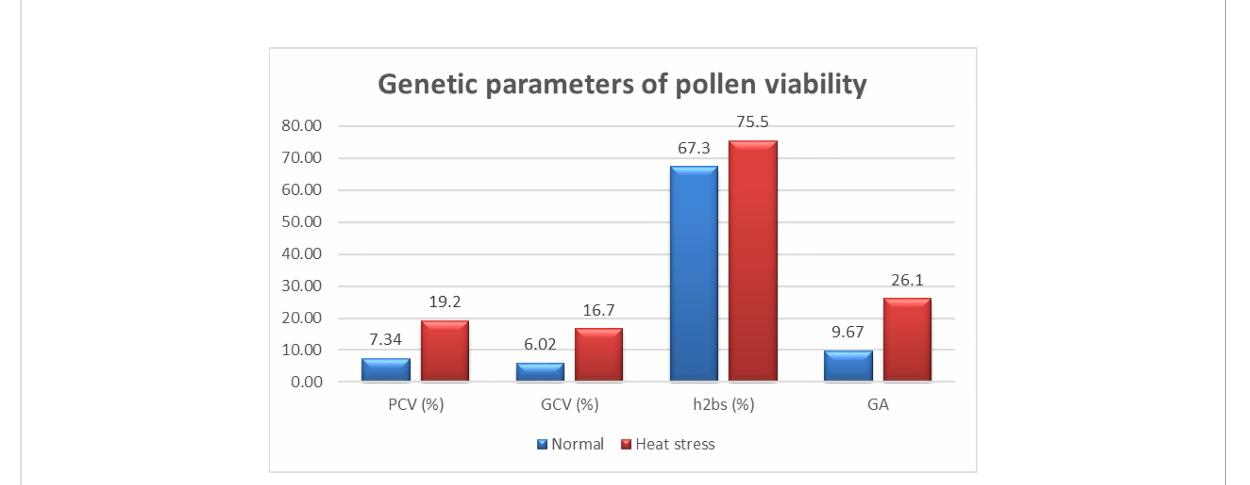
FIGURE 6 Genetic parameters for pollen viability (%) under normal and heat stress